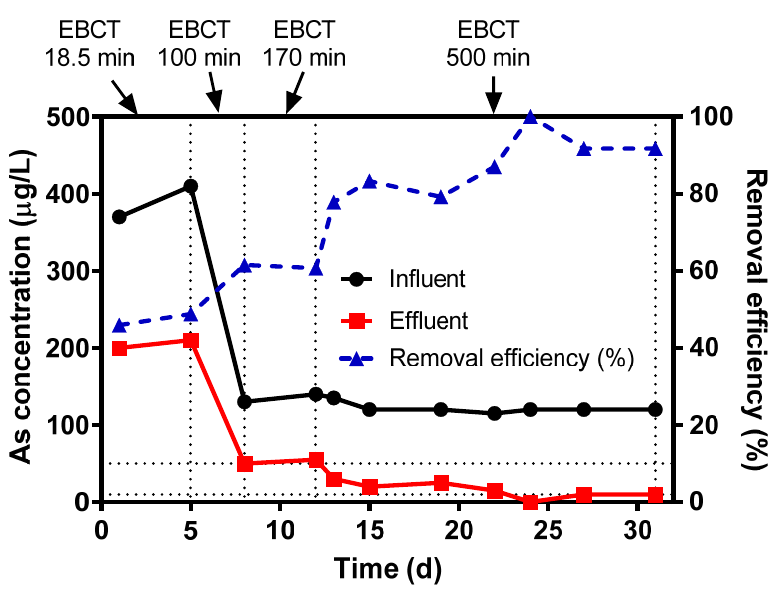
Figure 7. Results from pilot-scale experiments of arsenic removal by using MIRESORB TM as an adsorbent material.